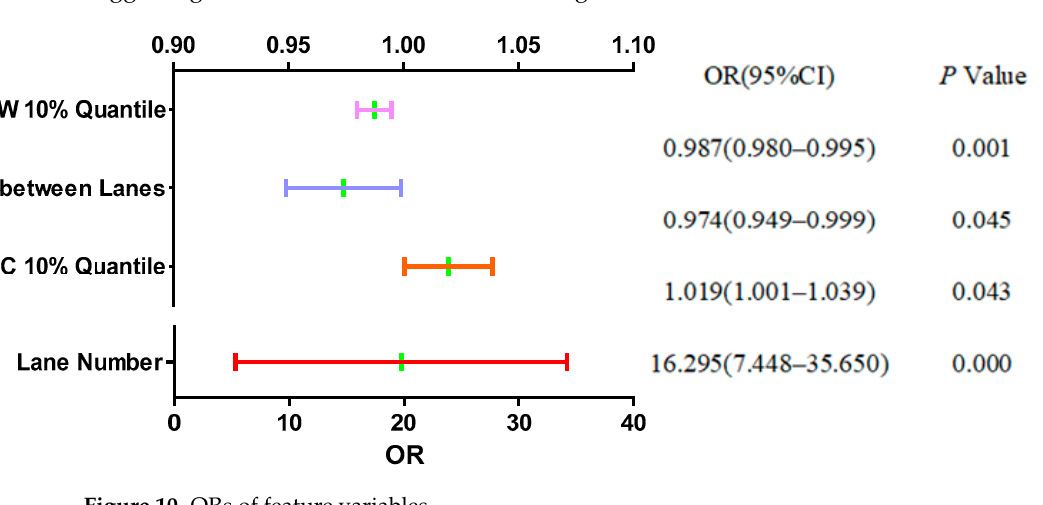
Table 3. Results of regional risk prediction model.